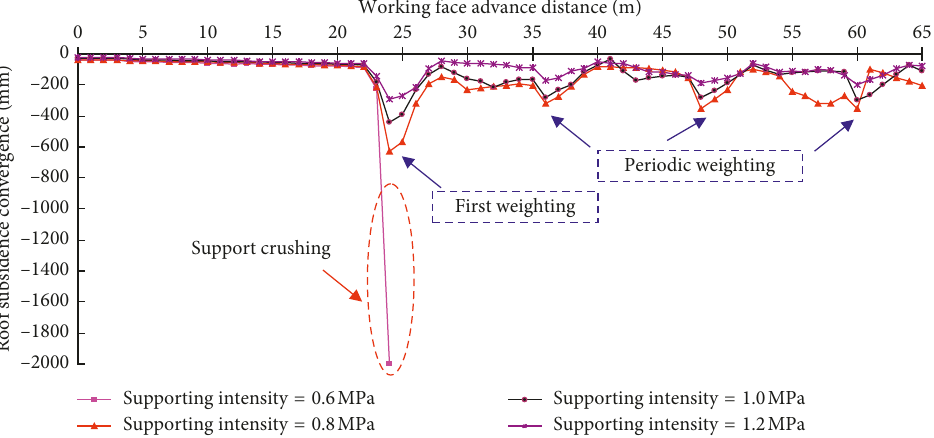
Figure 3: Variation of roof subsidence convergence with working face advanced distance.